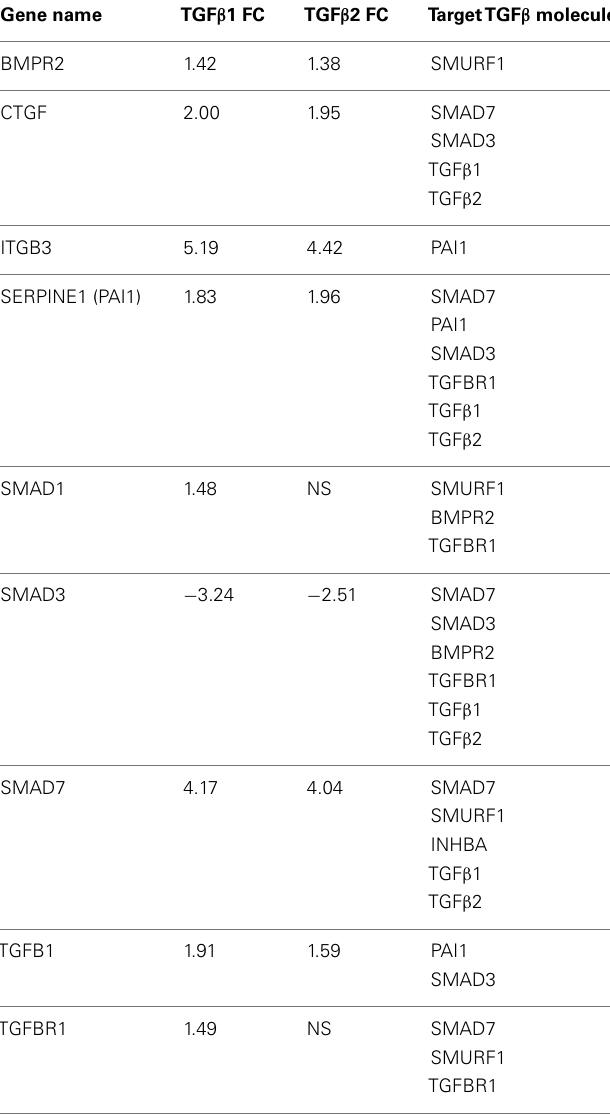
Table 3 | List of differentially expressed genes targetingTGF β signaling